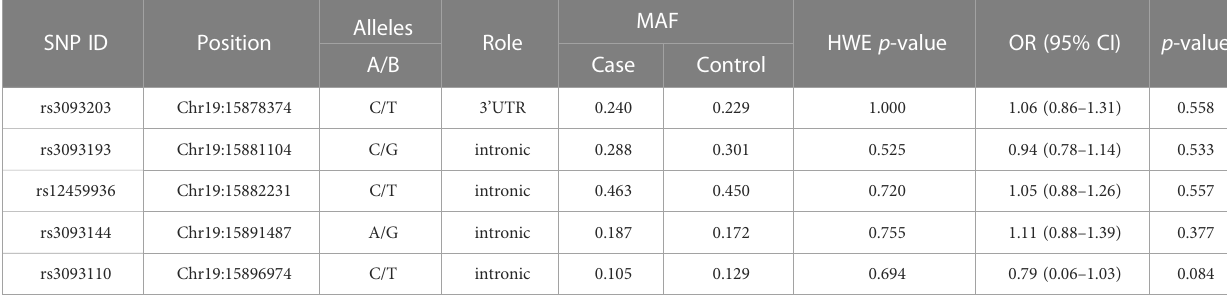
TABLE 2 Basic information and allele frequencies of candidate SNPs in